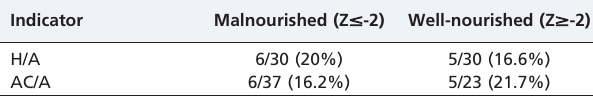
Table 4 - Frequency of mortality among malnourished and well-nourished children assessed by H/A and AC/A after liver